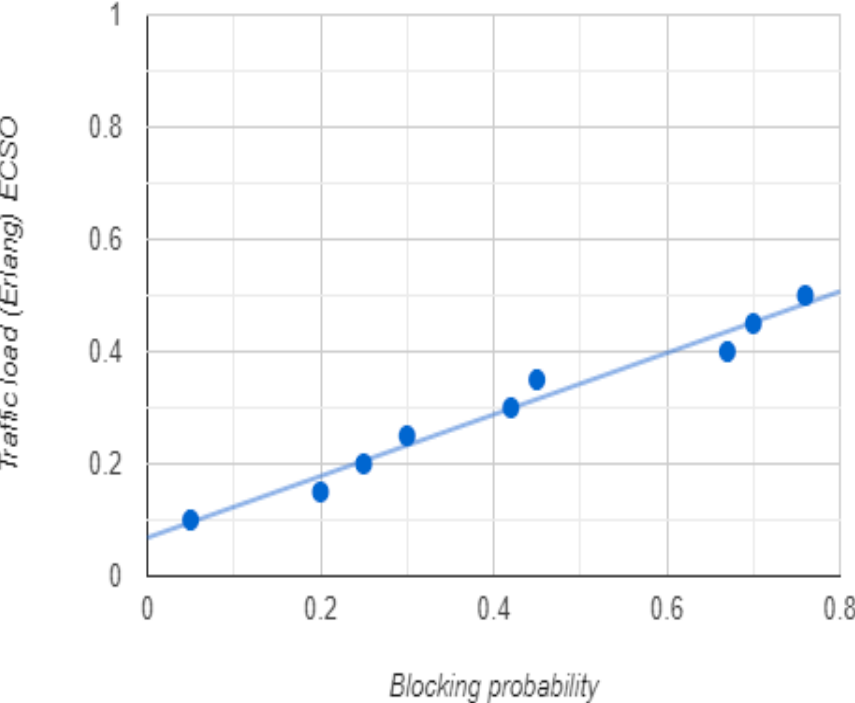
Figure 4. Blocking probability versus traffic load.